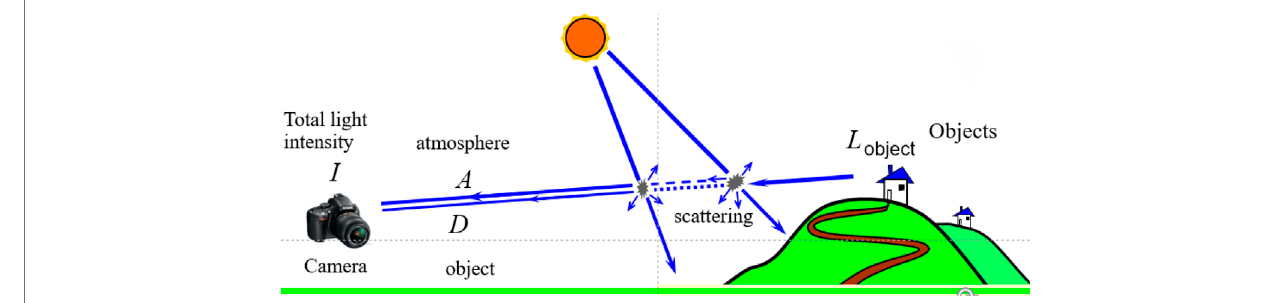
FIGURE 6 | Atmospheric scattering imaging link.